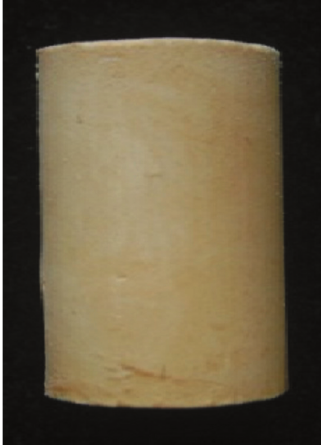
Figure 2- Sample used for compressive strength test